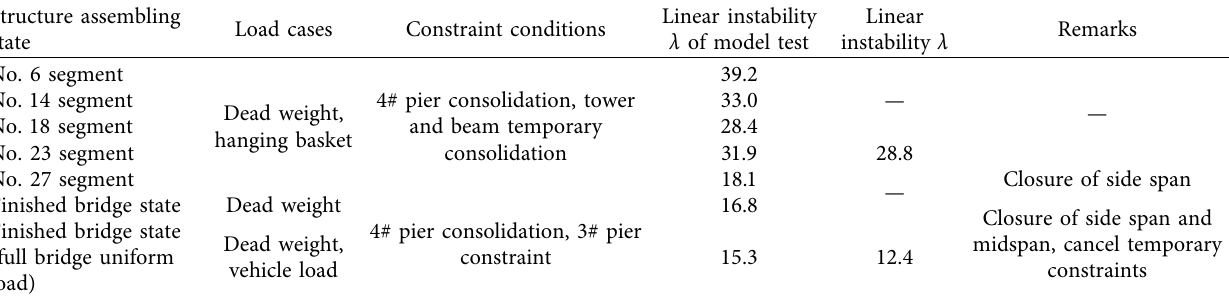
Table 1: Linear stability analysis situation of key